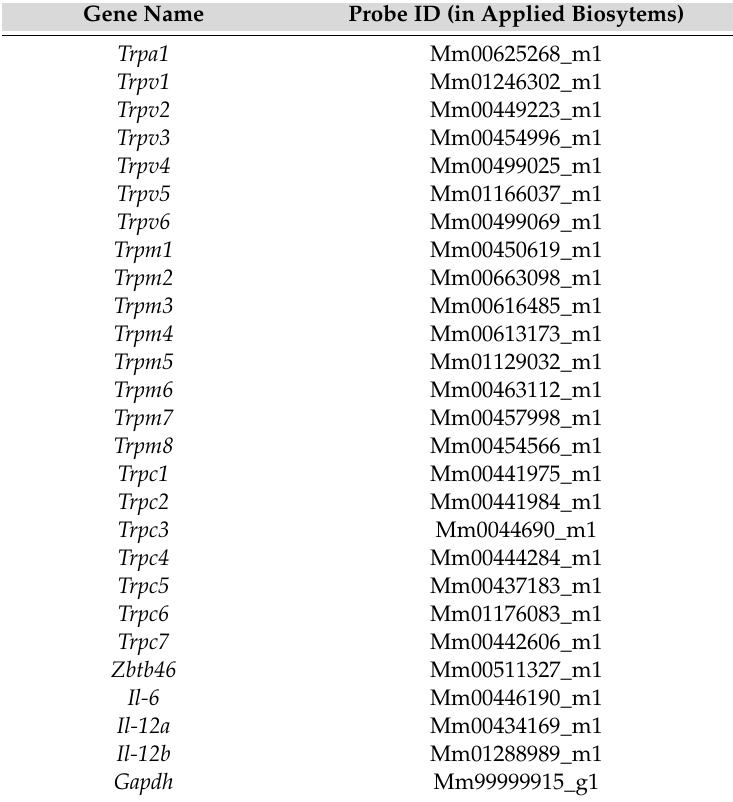
Table 1. List of TaqMan